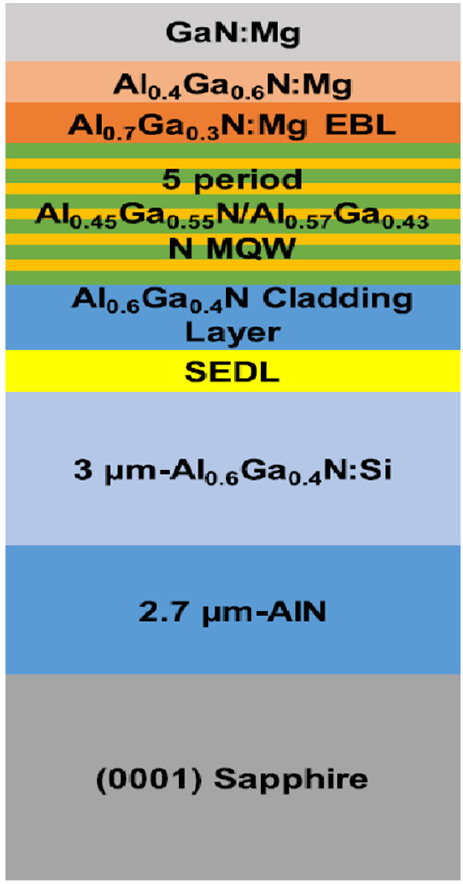
Figure 6. A schematic of DUV-LED structure with chirped SEDL. [23] Copyright 2018, AIP Publishing.